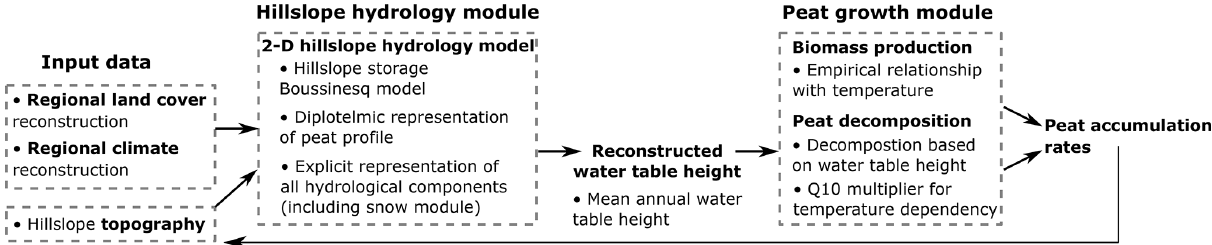
Figure 2. General model workflow. For a more detailed description of the model structure, the reader is referred to the